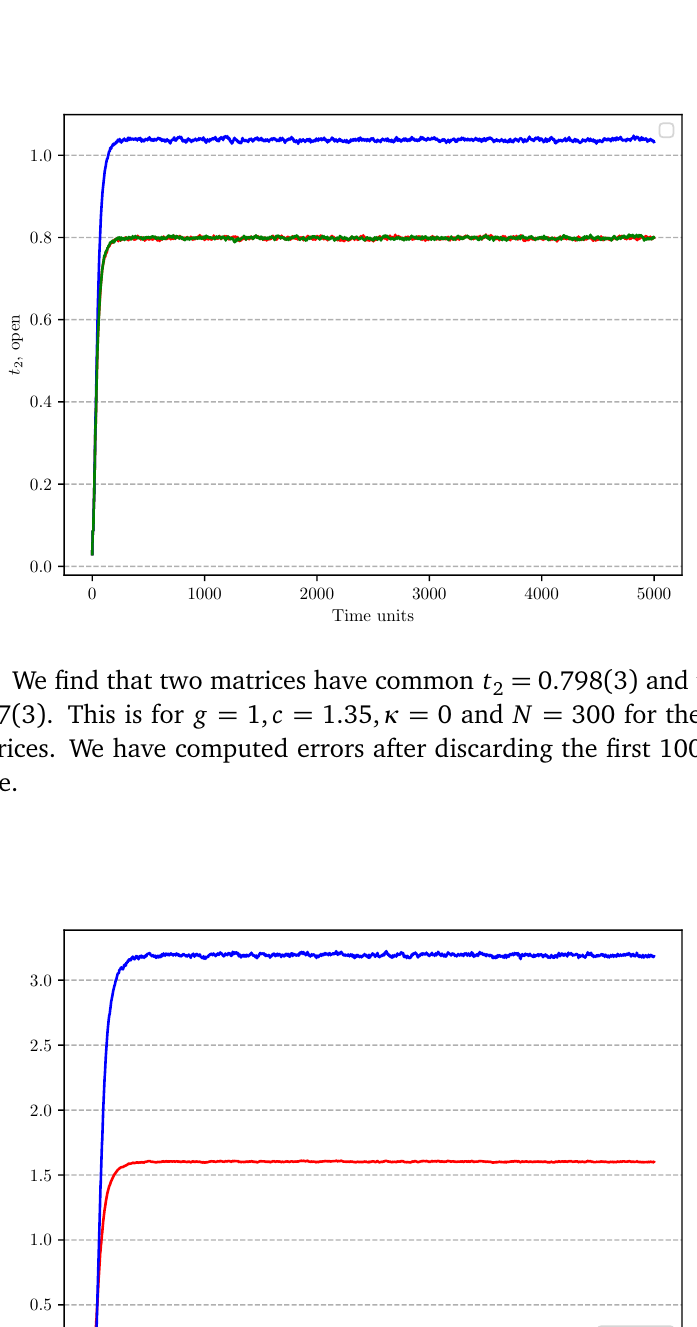
= 1.603 ( 5 ) Figure 13: We find that for closed model with three matrices we find t 2 = 3.193 ( 5 ) . This is for g = 1, c = κ = 1.35 for N = 300. We have com- and t 4 puted errors after discarding the first 1000 time units and using jackknife block- = t / 2. We found that for ing. Note that for this set of parameters it seems like t 2 4 = 0.775 ( 2 ) and t = 0.887 ( 3 ) . It is straightforward to under- g = 2, c = κ = 1.35, t 2 4 stand the behaviour as a function of g at fixed c , κ if that is of interest to the reader by using the codes we